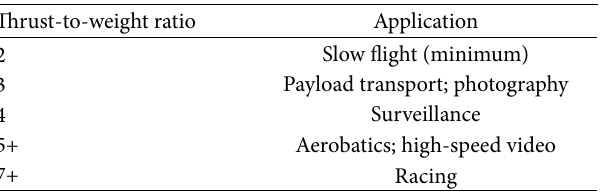
Table 1: Typical applications for multirotors of different thrust-to- weight